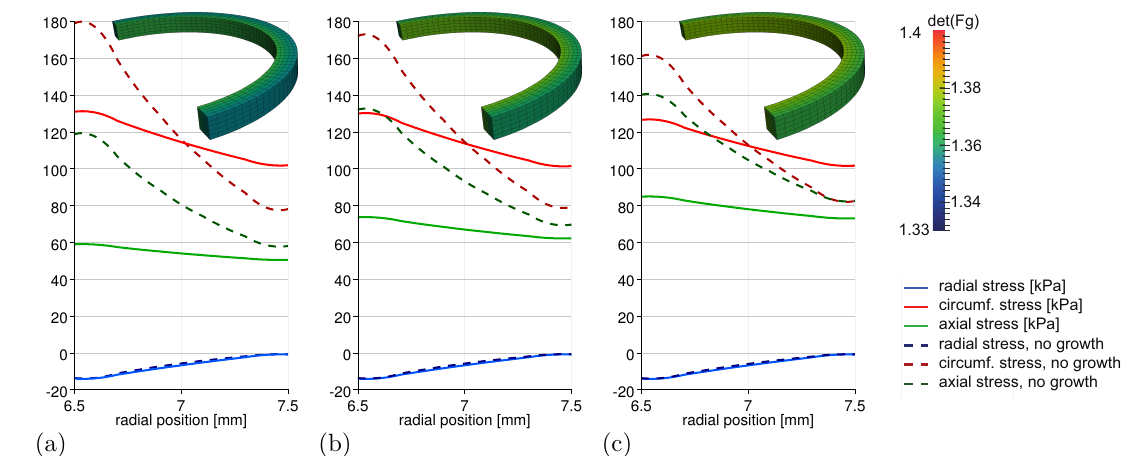
Figure 2. Radial, circumferential and axial stress distributions as well as growth deformation at t = 12 s in an arterial segment exposed to an internal pressure of 16 kPa and different axial displacements of (a) 10 %, (b) 15 % and (c) 20 % of the initial length. The dashed lines indicate the stresses of a non-growing arterial segment.